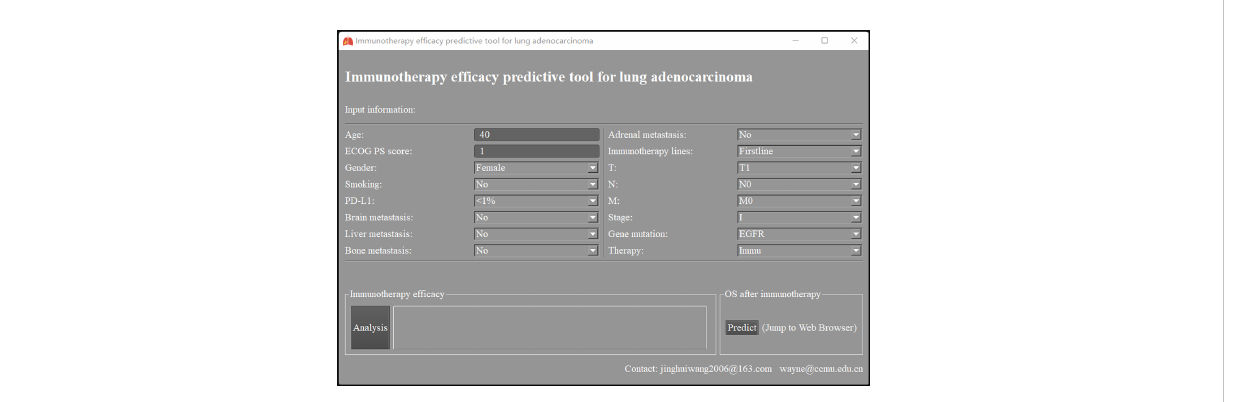
FIGURE 4 The interface of immunotherapy ef fi cacy predictive tool for lung adenocarcinoma based on neural network. ECOG PS score, Eastern Cooperative Oncology Group performance status score; PD-L1, programmed cell death ligand 1; Immu, immunotherapy; OS, overall